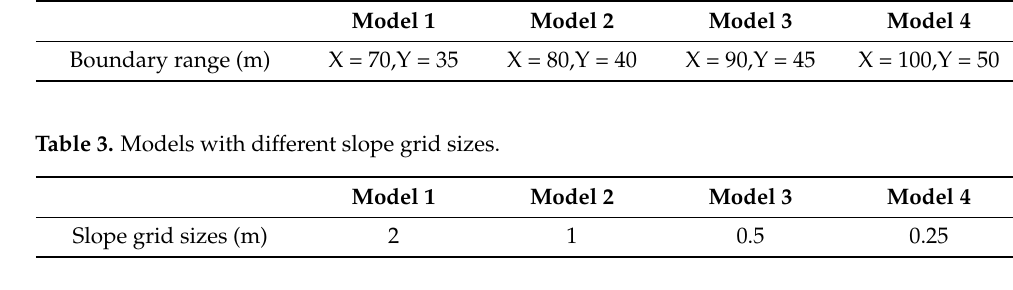
Table 2. Models with different boundary ranges.